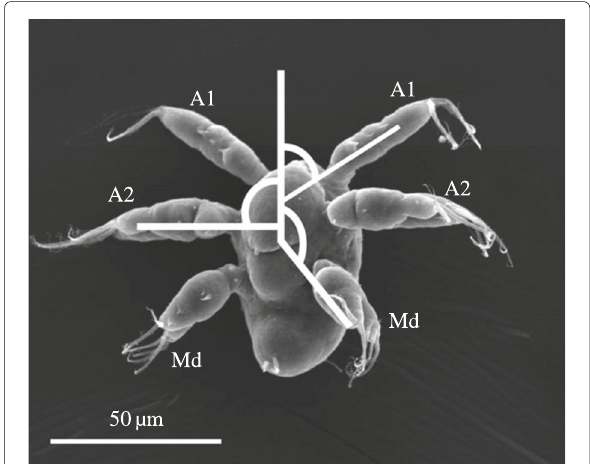
Fig. 19 Scanning electron microscopy image of a larval copepod, courtesy of Jenn Kong and reproduced from [29]. Copyright retained by the